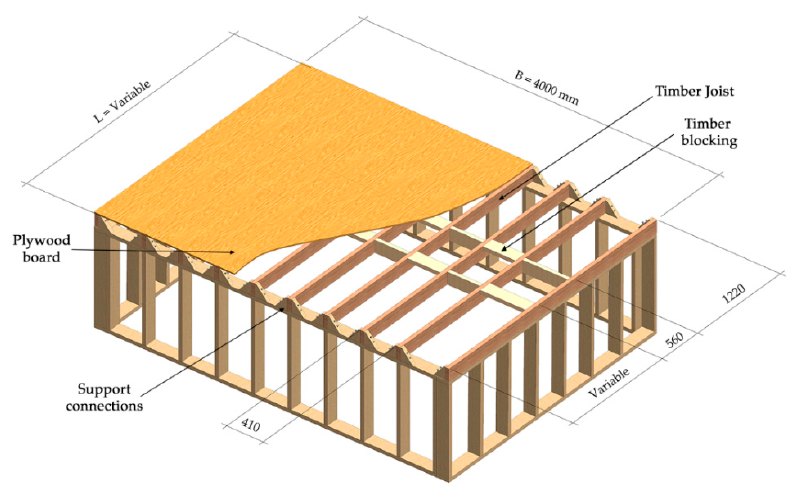
Figure 2. Layout and dimensions of a typical laboratory test specimen.